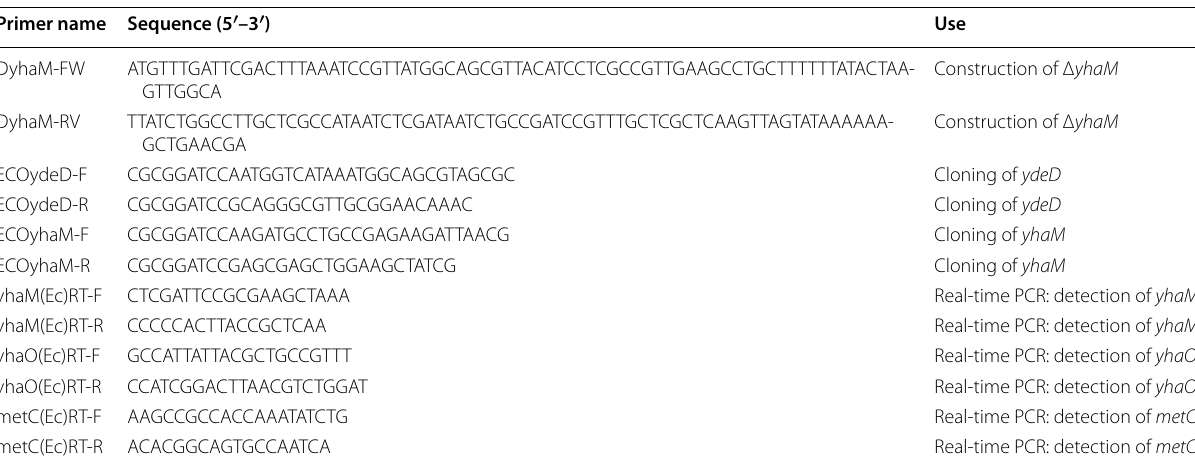
Table 2 Oligonucleotides Primer name Sequence (5 ′ –3 ′